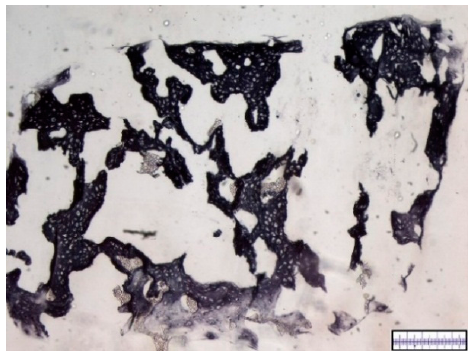
Figure 10. Representative slide of an Actifit ® scaffold after 21 days of in vitro chondrogenesis. Collagen